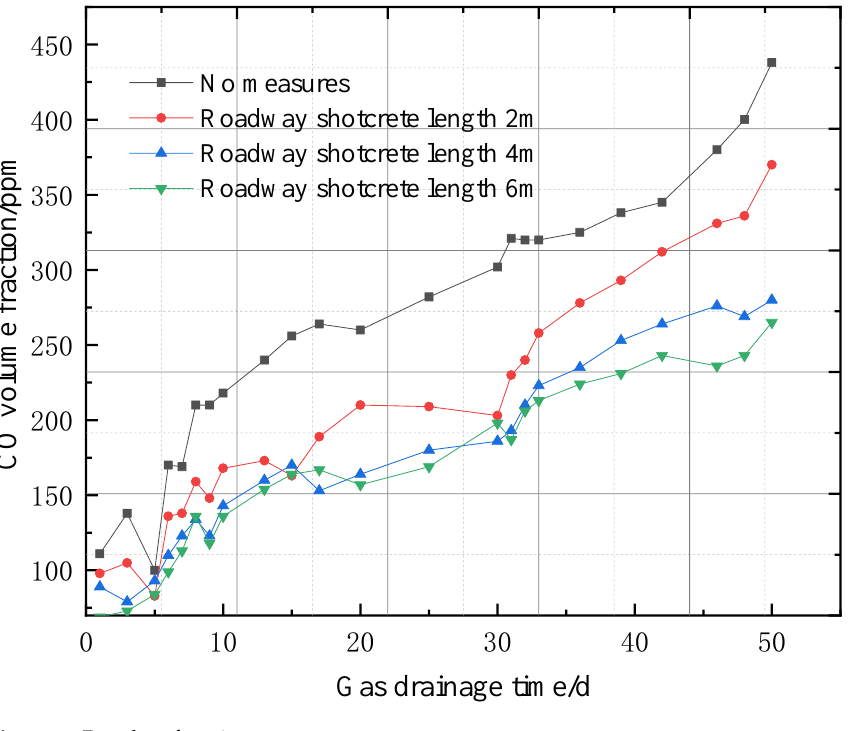
Figure 7. Results of testing.